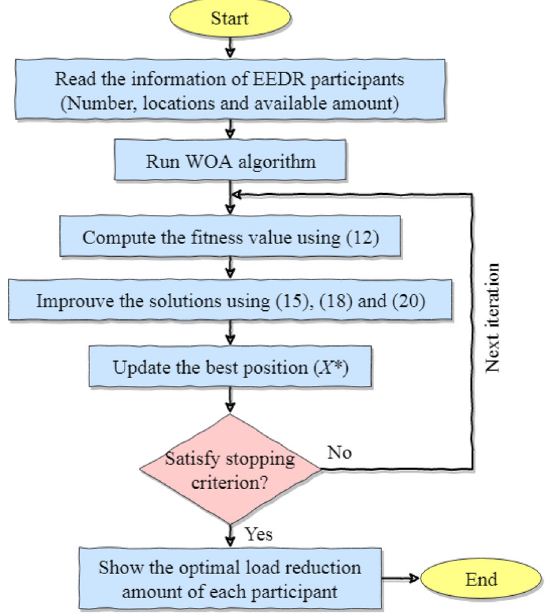
Fig. 7 Flowchart illustrating the process of demand reduction amount optimization using WOA